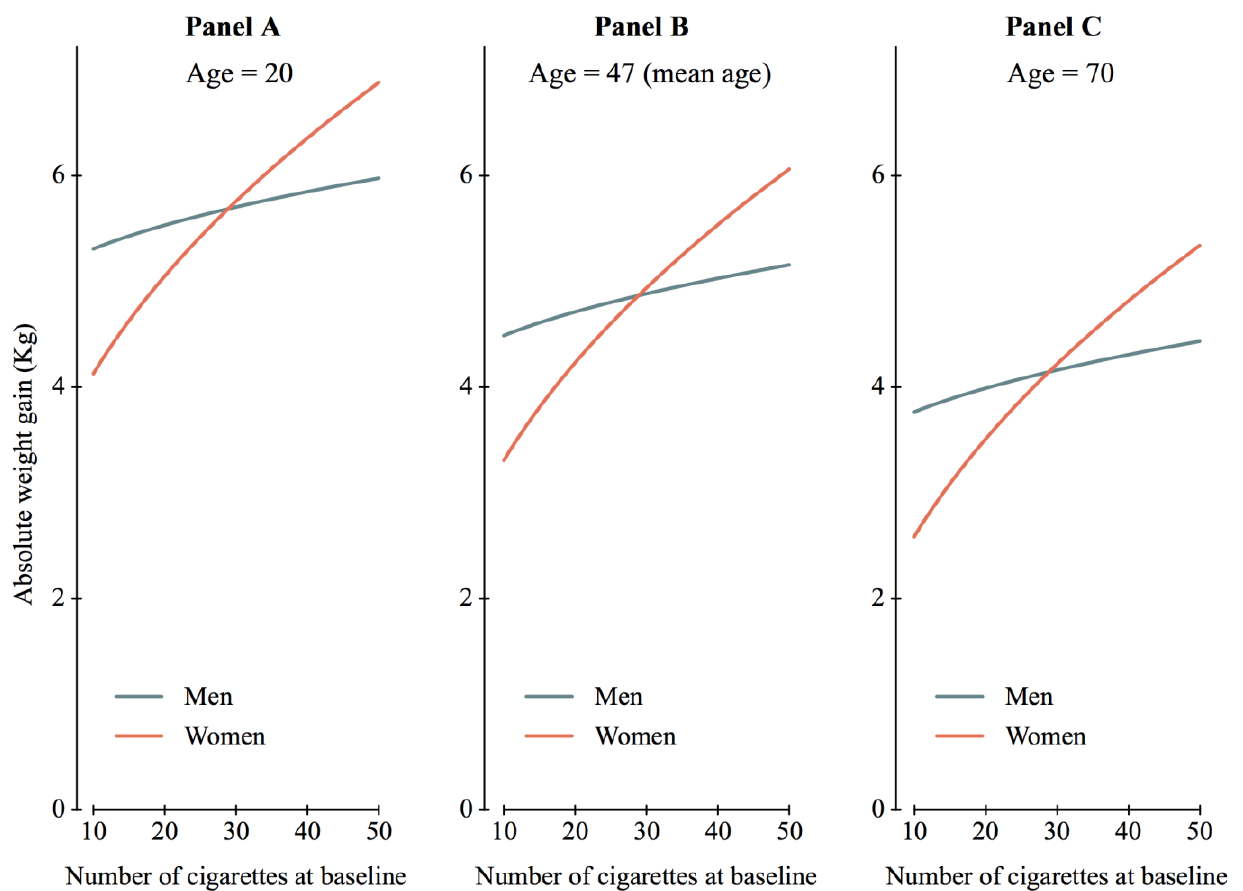
Figure 3. Mean absolute weight gain according to the multivariate model as a function of age, sex and number of cigarettes smoked at baseline. Overall duration of abstinence more than 40